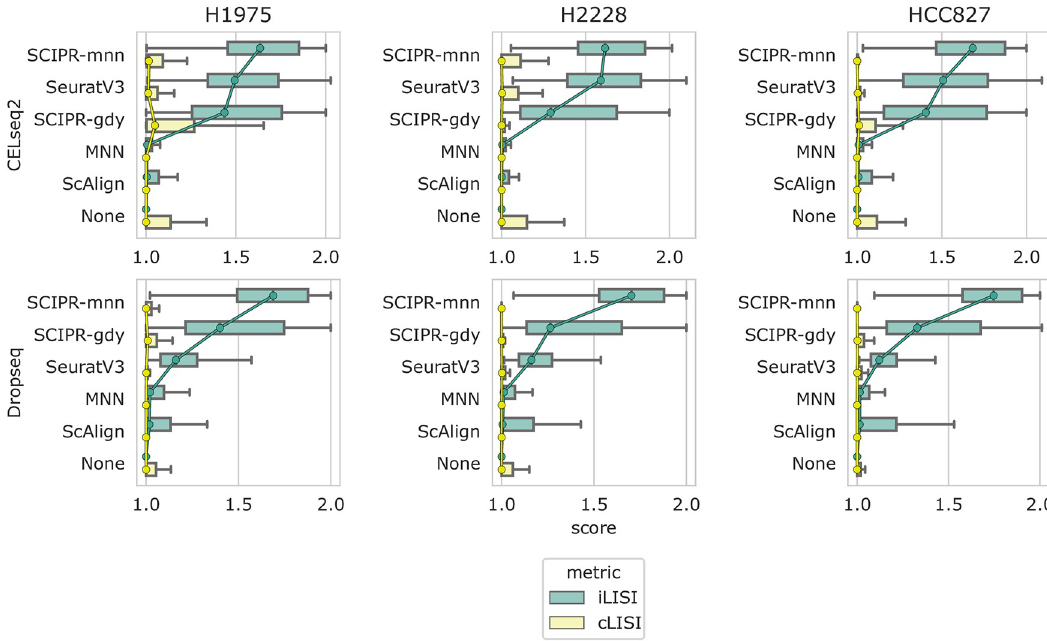
Fig 4. Quantitative scoring of alignment methods on the CellBench dataset with a cell type held out from the target set. Each row of subplots are alignment tasks with the same source batch, where each column uses a different cell type as a hold-out from the target set (the 10x batch). Box plot computation and ordering of methods in each subplot is determined in the same fashion as in Fig